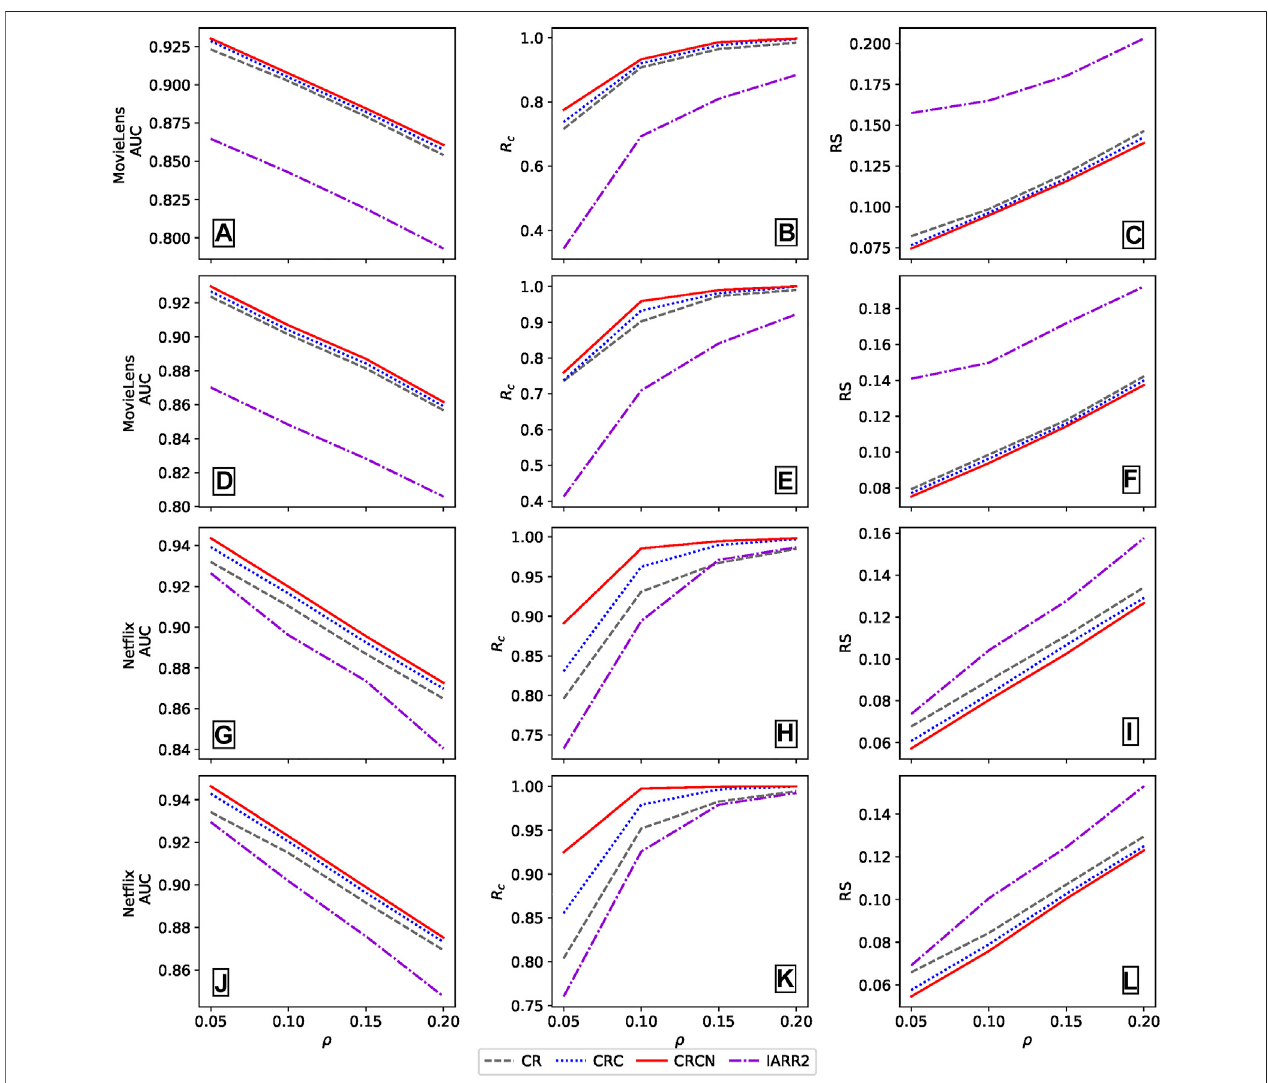
FIGURE 7 | The AUC, R c and RS values of different methods with different ω and ρ in the random spammers for (A-F) MovieLens and (G-L) Net fl ix data sets, respectively. Each row represents a different parameter ω : a-c ( ω = 0.75); d-f ( ω = 0.1); g-i ( ω = 0.02); j-l ( ω = 0.03). The results are averaged over 10 independent